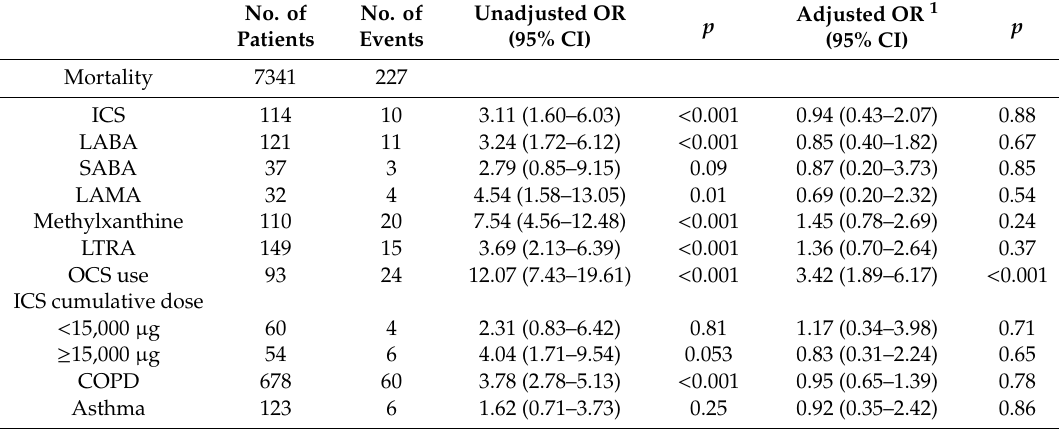
Table 2. Risks of mortality and respiratory outcomes according to drug exposure, COPD, and